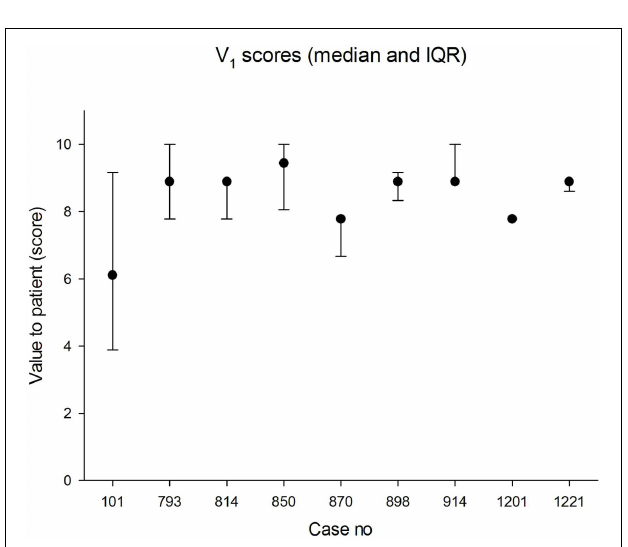
FIGURE 4 | Median scores for value to the organization (0 = worst; 10 = best) .The error bars indicate the 25th and 75th